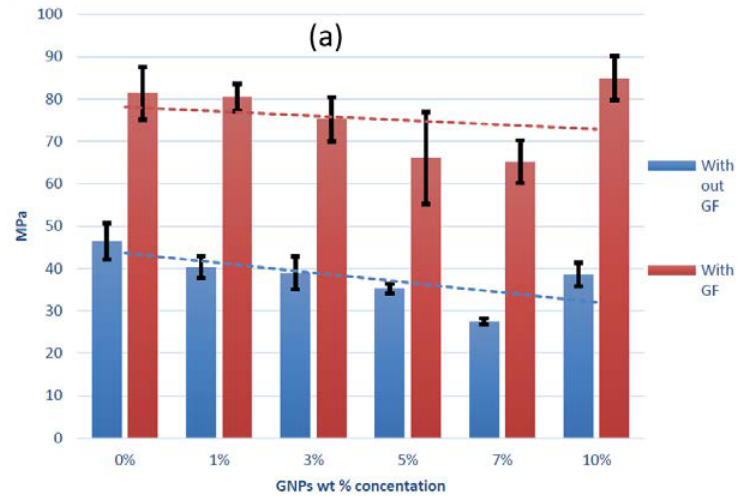
Figure 3. Transverse and in-plane conductivity of ( a ) unfilled and ( b ) GF-reinforced polyester as a function of the graphene concentration. The transverse conductivity was assumed to be the real part of the complex conductivity at 0.1 Hz while the in-plane conductivity was measured by the four-point technique. The latter measurement was conducted both on top of the flat section (top) and on the side section (cross) of the samples, yielding similar